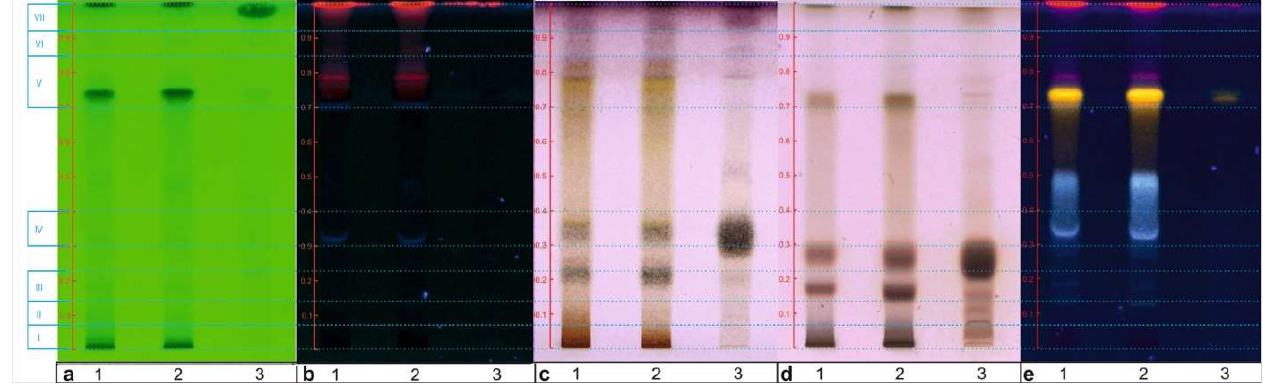
Figure 1. Chromatograms of S. rubriflora extracts: (1) S. rubriflora M leaves; (2) S. rubriflora F leaves; (3) S. rubriflora fruits; ( a ) 254 nm; ( b ) 366 nm; ( c ) AS (VIS); ( d ) thymol (VIS); ( e ) NP-PEG (366 nm). Mobile phase: F1; applied volume: 5 μL.